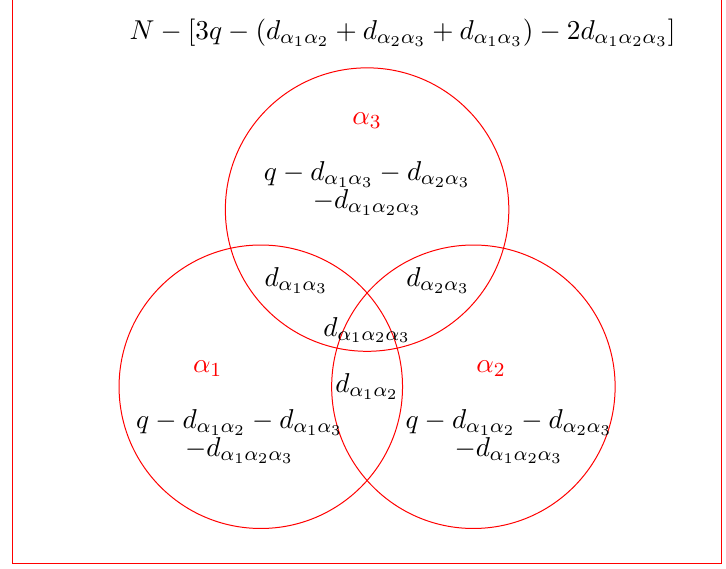
Figure 4 . Venn diagrams with three index sets. There are eight regions, each labeled by its own